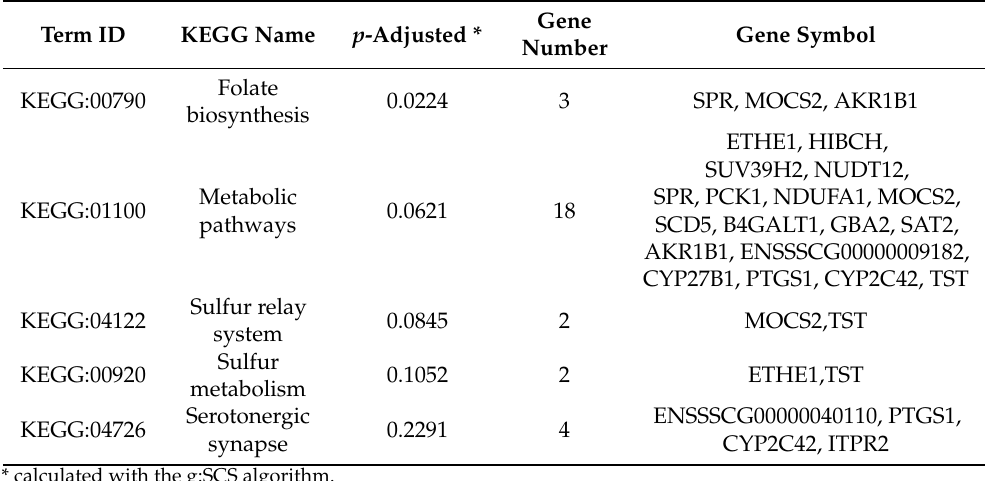
Table 4. The results of the Kyoto Encyclopedia of Genes and Genomes (KEGG) pathways for differentially expressed genes (DEGs) detected in resiniferatoxin (RTX)-treated samples.